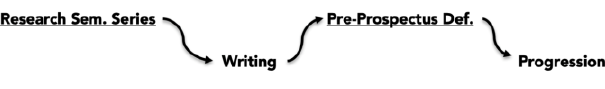
Figure 2. Logic Model of the Anticipated Impact of Revised Research Seminar Series on Dissertation Progression